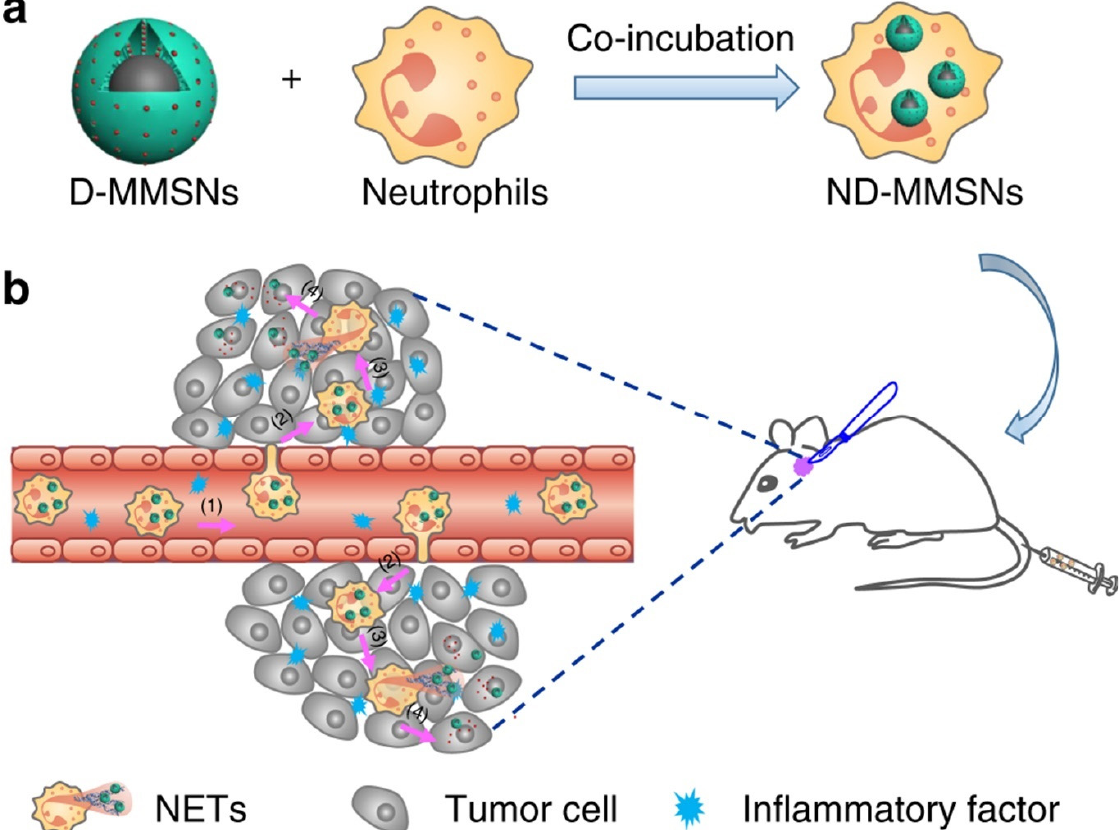
Figure 1. Fabrication and targeted-therapeutic schematics of ND-MMSNs to achieve residual tumor theranostics. ( a ) Sche- matic illustration of the preparation of ND-MMSNs. ( b ) Schematic shows that inflammation-activatable ND-MMSNs tar- get inflamed glioma sites and phagocytized D-MMSNs would be released to achieve residual tumor theranostics [47] (CC by